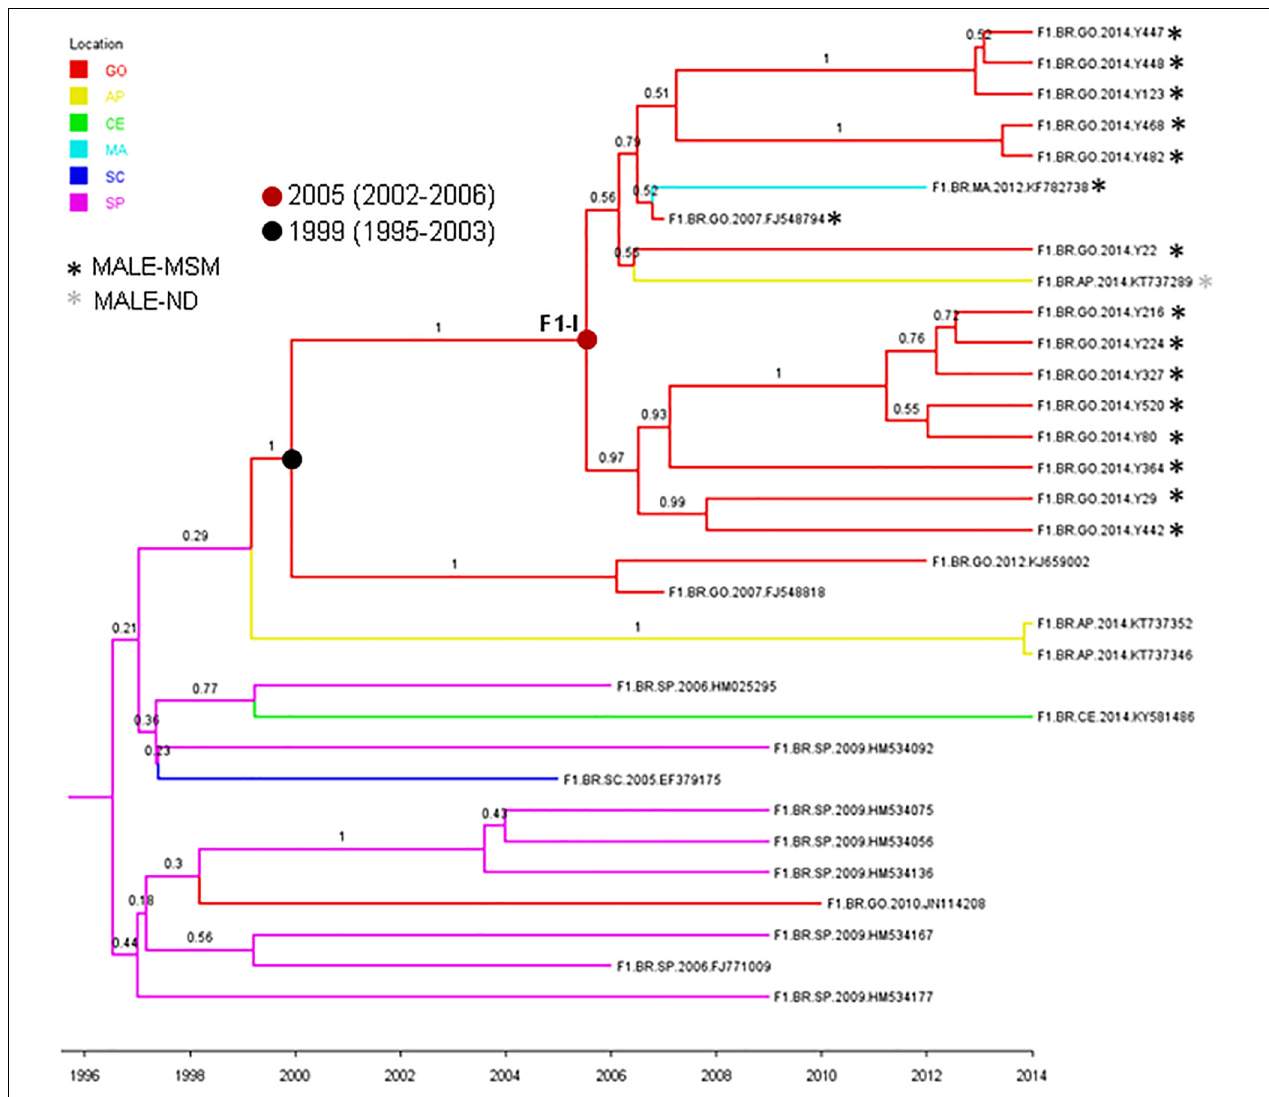
FIGURE 5 | Time-scaled Bayesian Markov Chain Monte Carlo (MCMC) tree of 14 HIV-1-subtype F1 pol sequences from MSM from Central-Western Brazil and related sequences. Branches are colored according to the most probable location state of their descendent nodes as indicated in the legend at the upper left side. Sequences are marked with an asterisk colored according to the risk group. Internal circles indicate the positions of the ancestral of nodes of the major F1-I MSM cluster (red circle) and of basal related sequences from Goiás state (black circle). The T MRCA of those clusters are indicated. Numbers at ancestral nodes indicate the clade support ( PP ). Branch lengths are depicted in units of time (years). The tree was automatically rooted under the assumption of a relaxed molecular clock. Location states: Goiás (GO), yellow to Amapá (AP), green to Ceará (CE), light blue to Maranhão (MA), dark blue to Santa Catarina (SC), and rose to São Paulo